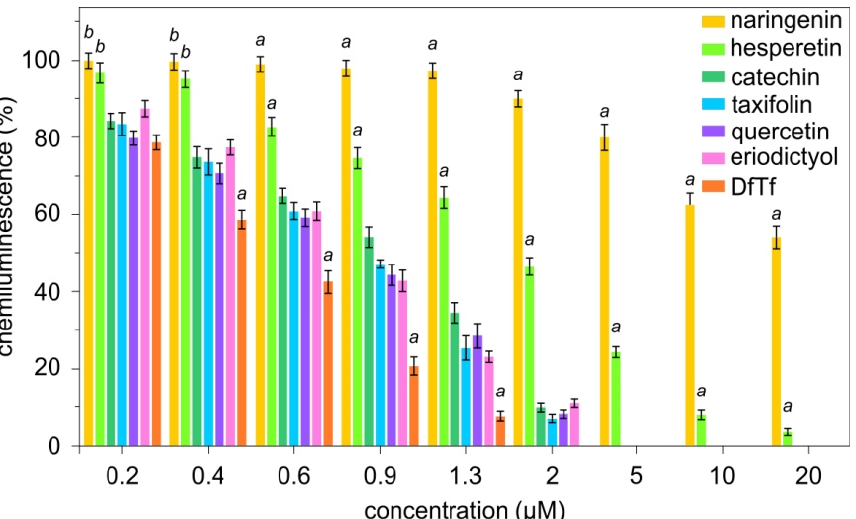
Figure 2. Effect of polyphenols on chemiluminescence. a differences are significant compared with other compounds; b differences are significant compared with catechol-containing compounds, p < 0.05.